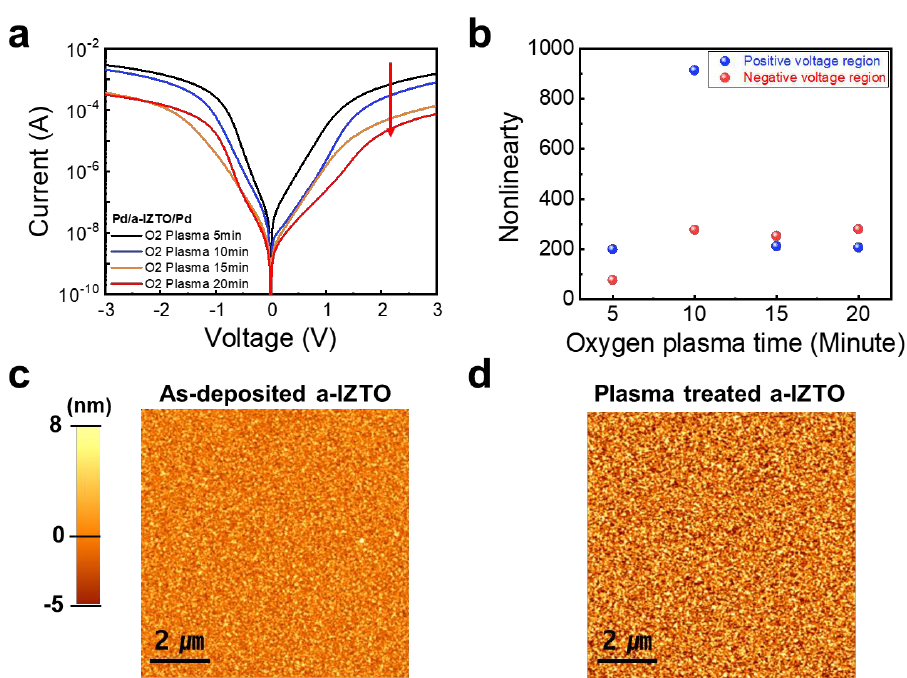
Figure 2. ( a ) I-V characteristics of a-ITZO-selector device depending on the process time of oxygen plasma treatment. As shown in the red arrow, the current decreases as the O 2 plasma time increases. ( b ) Nonlinearity value of a-ITZO-selector device as a function of oxygen plasma process time. AMF image of a-ITZO surface ( c ) before and ( d ) after oxygen plasma treatment.